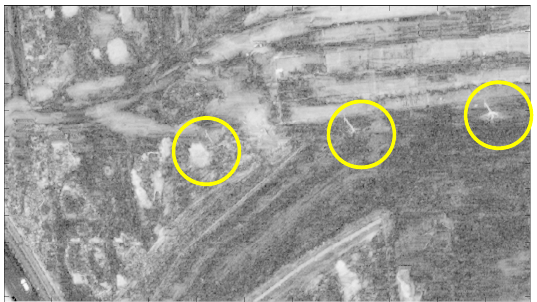
Figure 6. Disparity Map using Graph-Cut algorithm (Detect poles and power lines seems some extent and also the vegetation in white color, well smooth, less